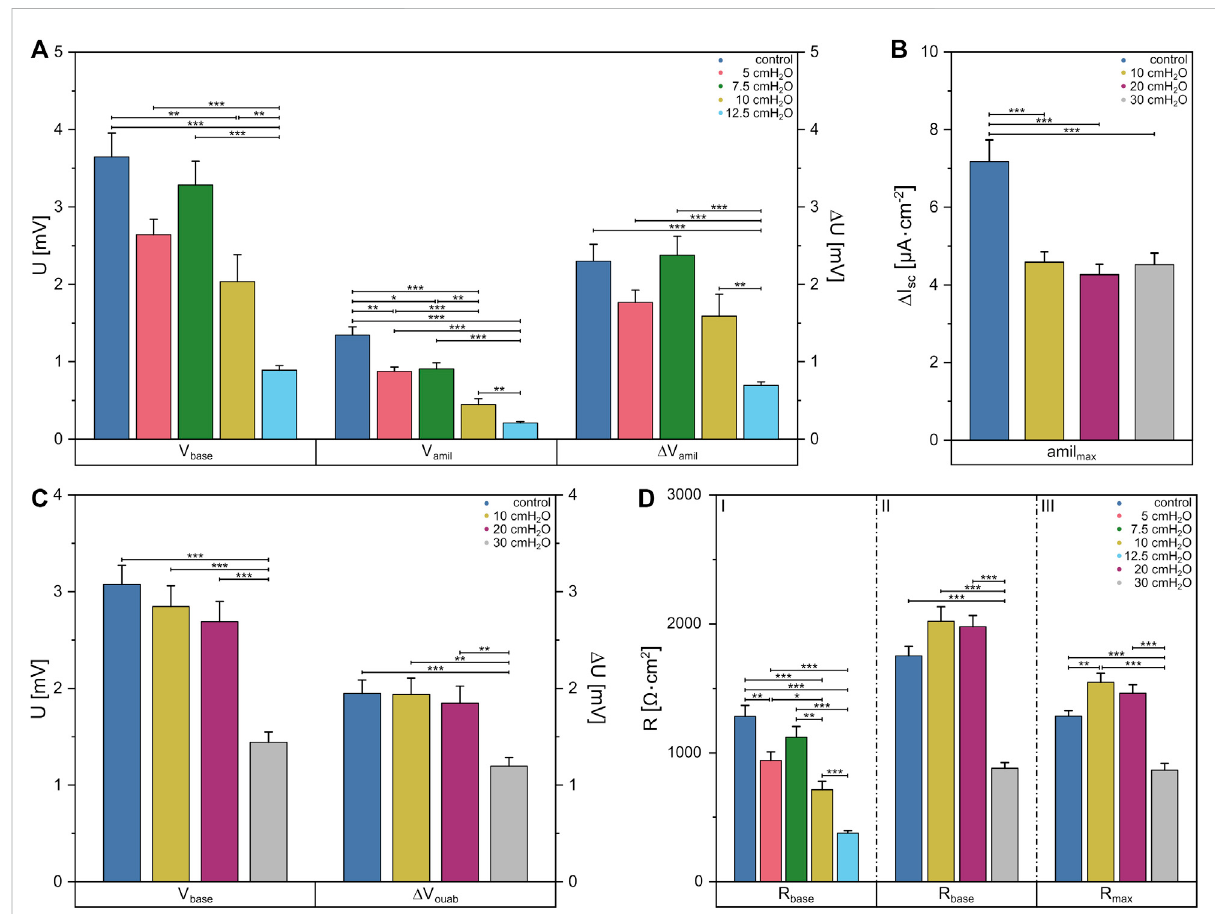
pressure. Column diagram of (A) V te under basal conditions ( V base ), amiloride-insensitive V te ( V amil ) and the amiloride-sensitive V te ( Δ V amil ) with basolateral fl uidcolumns, (B) theamiloride-sensitivecomponentoftheamphotericin-inducedmaximal I sc ( amil max )withapical fl uidcolumnsand (C) V te under basal conditions ( V base ) and the ouabain-sensitive V te ( Δ V ouab ) with apical fl uid columns. (D) Column diagram of R te after I sc reached a stable plateau in amiloride (I) and ouabain (II) measurements or the maximum value in amil max (III) measurements, respectively. The columns represent the mean values emerging from individual measurements with application of different fl uid columns represented by